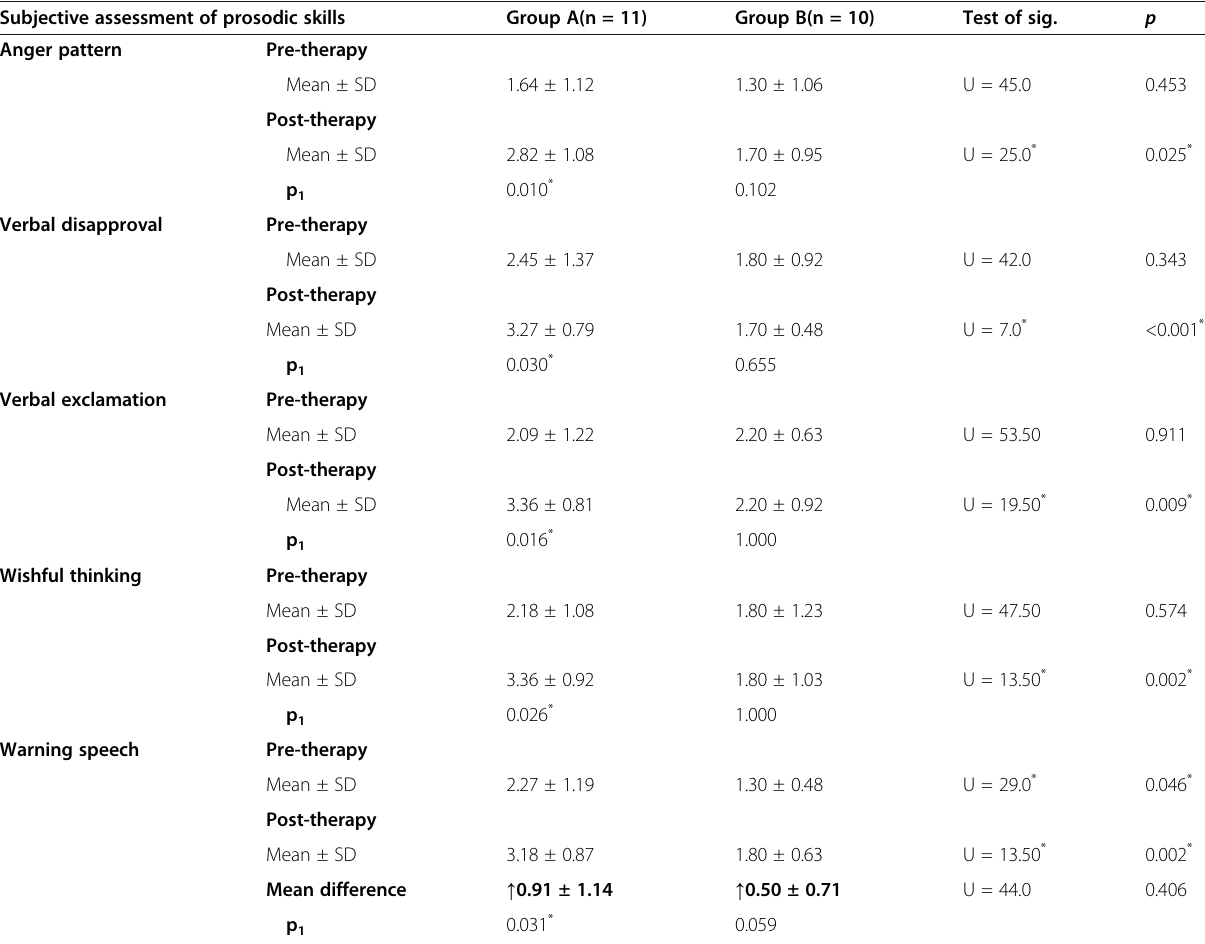
Table 4 Comparison between the two studied groups according to subjective assessment of prosodic skills Subjective assessment of prosodic